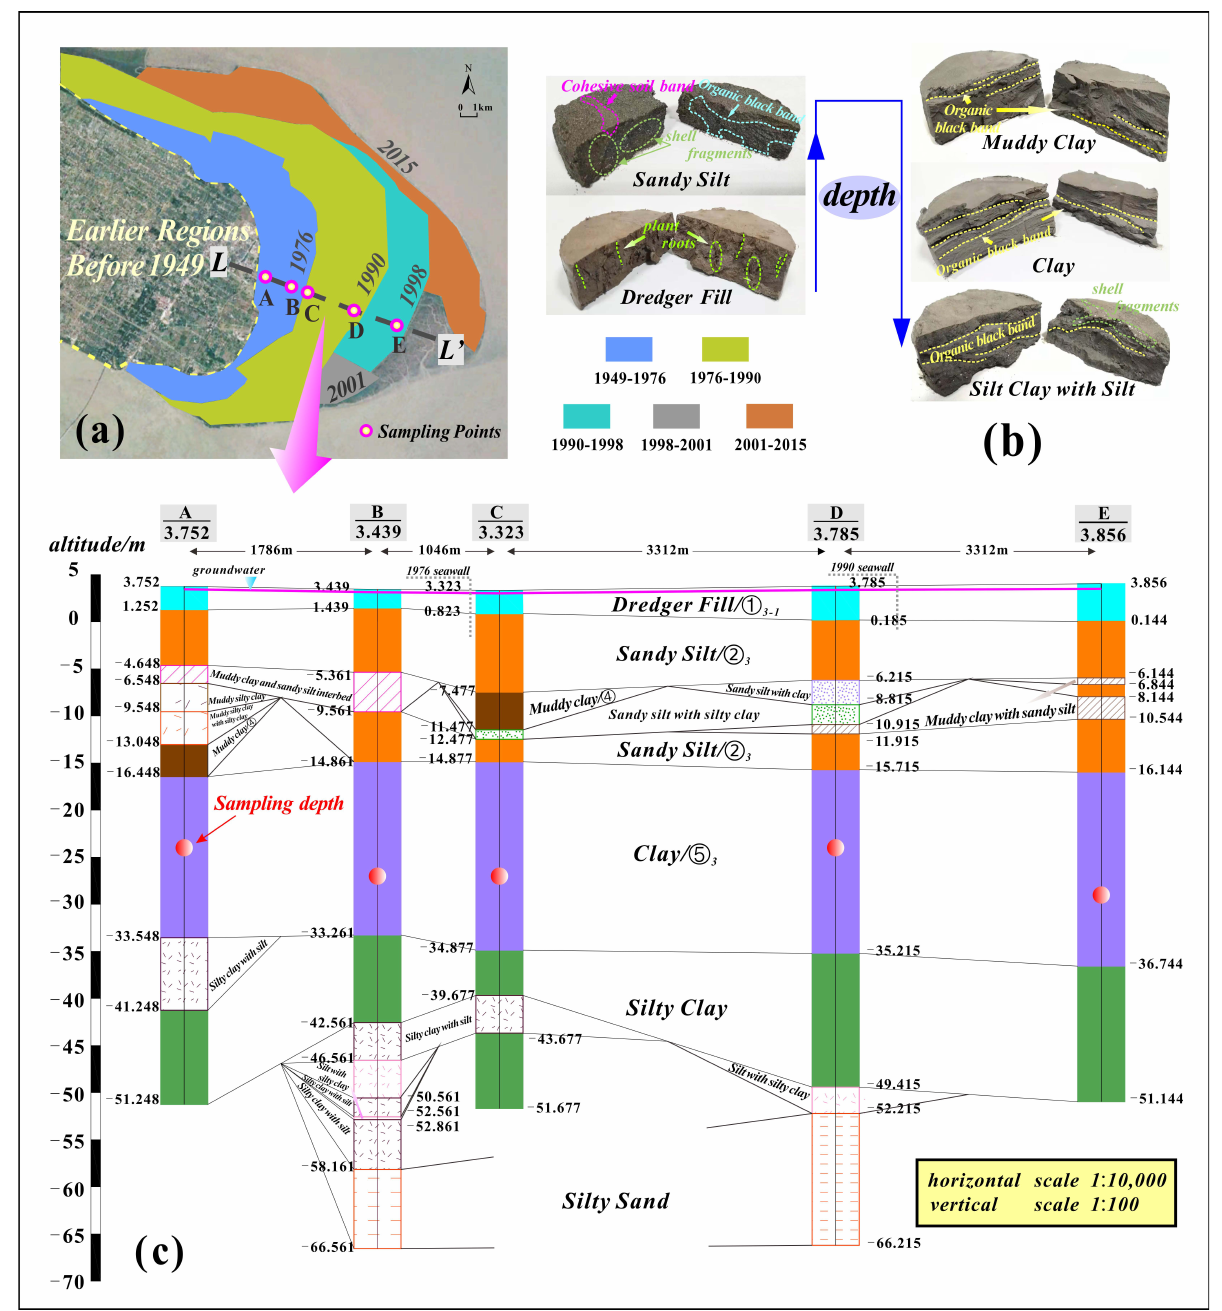
Figure 2. ( a ) Sampling points ( A–E ) at different phases; ( b ) sample photos of representative soil layers; ( c ) geological section map of borehole profiles based on field